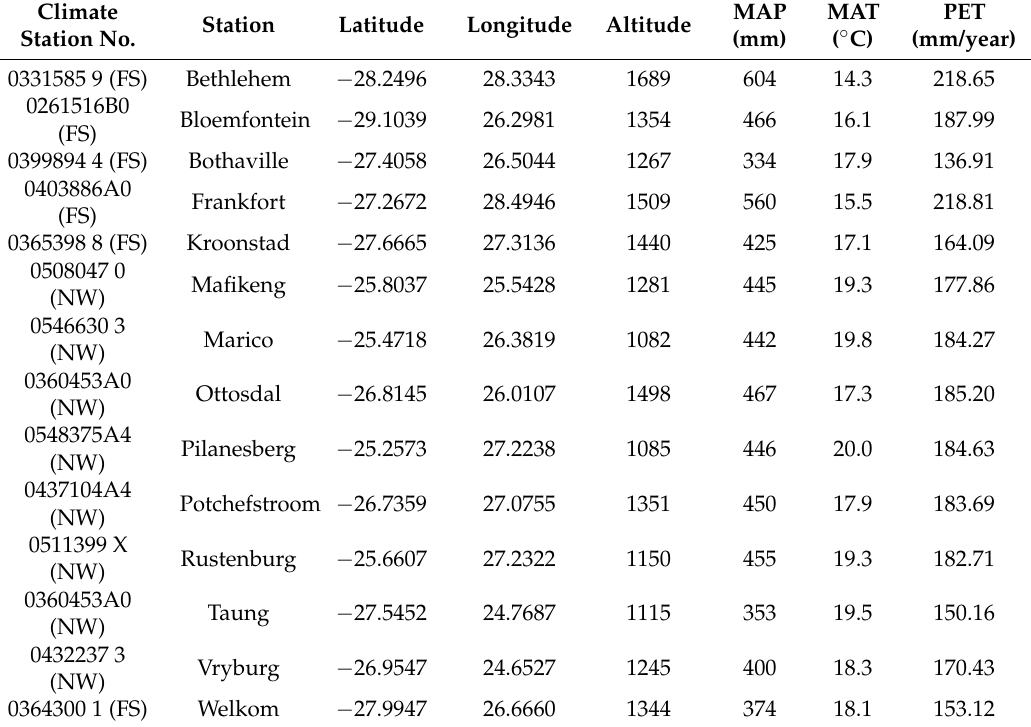
Table 2. List of climate stations used in the drought analysis study. The table summarizes the coordinates of the selected weather stations, including their altitudes, mean annual precipitation (MAP) in mm, mean annual temperature (MAT) in ◦ C and potential evapotranspiration (PET). Climate Station Latitude Longitude Altitude Station No.